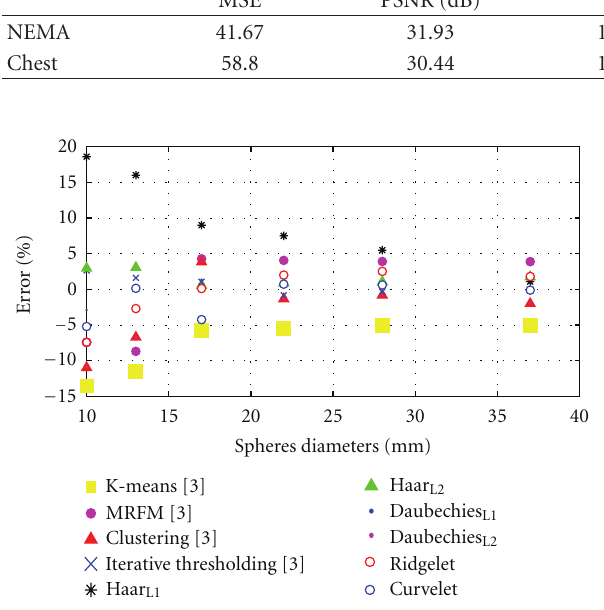
Figure 16: Visual comparison for error percentages in Table 2.